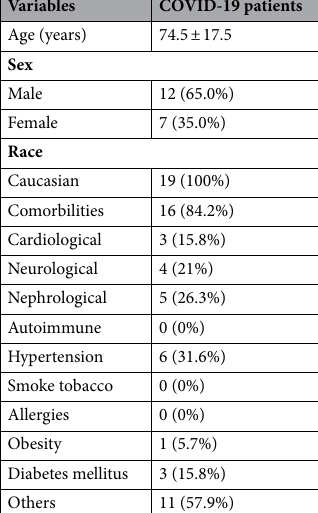
Table 1. Demographic and clinical characteristics of patients with